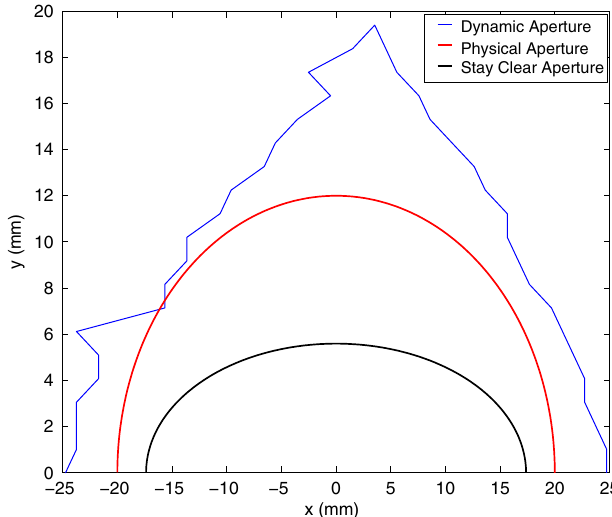
FIG. 4. The dynamic aperture in the booster compared to the physical and stay clear apertures at 200 MeV.